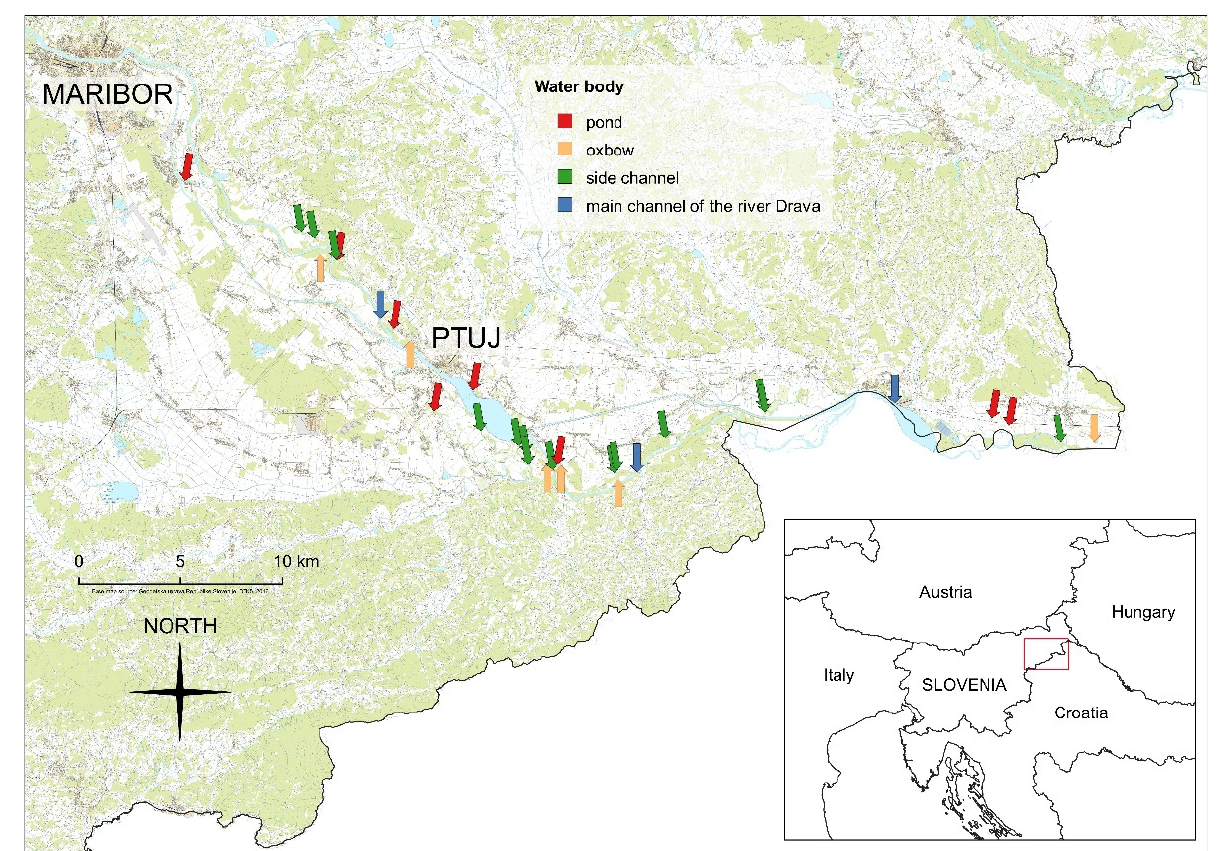
Figure 1. Distribution of the studied waterbodies in the floodplain of the Drava river (Base map source: Surveying and Mapping Authority of the republic of Slovenia (2016).